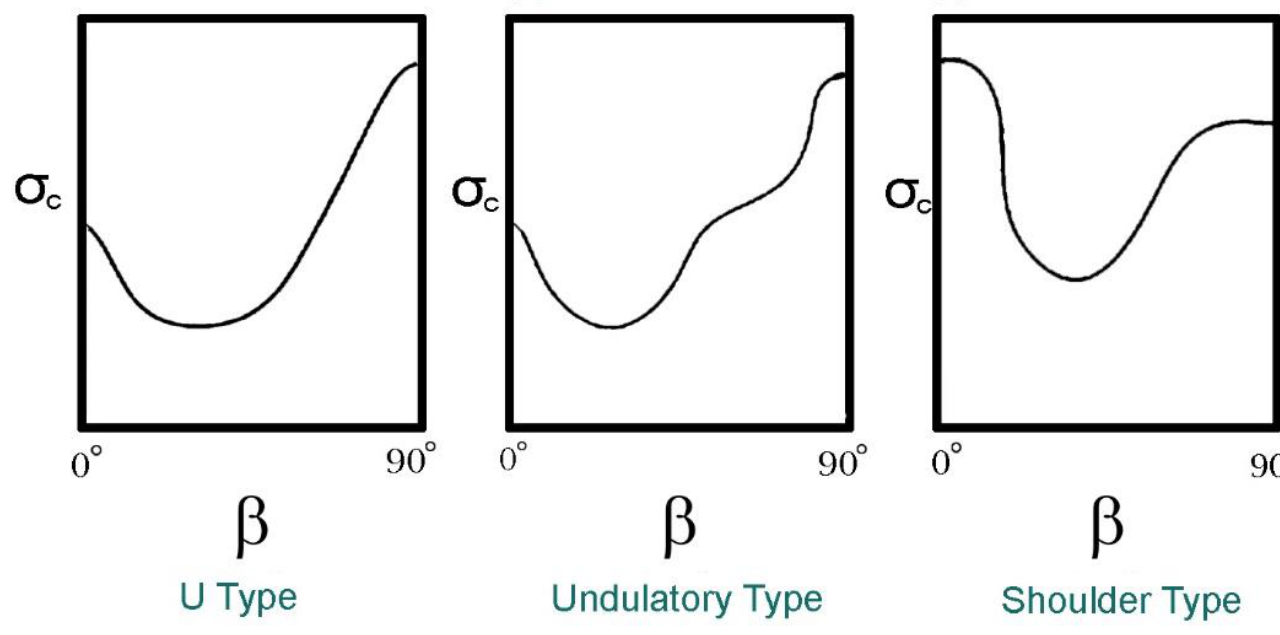
Figure 2. Classification of anisotropy for transversely isotropic rocks ( β is foliation angle, and σ c is uniaxial compressive strength of rock).